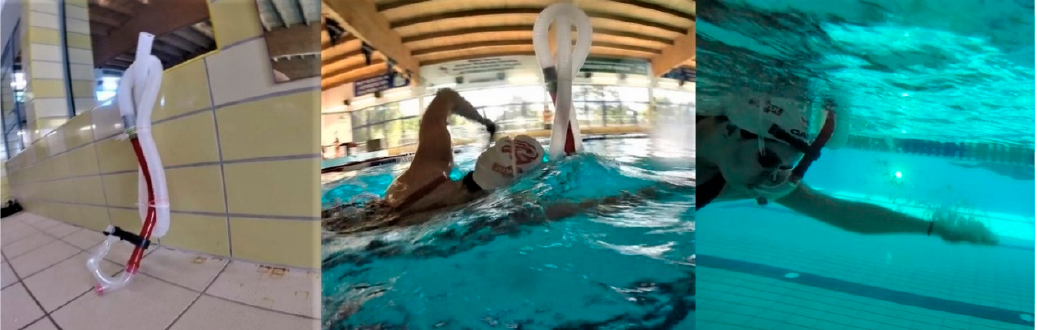
Figure 1. An instrument increasing added respiratory dead space: a custom added respiratory dead space (ARDS) apparatus consisting of a polypropylene centre-mount swimming snorkel with a mouthpiece (Speedo International Ltd., Nottingham, UK) integrated with 2.5-cm diameter ribbed tubing to provide 1000 mL of dead space.